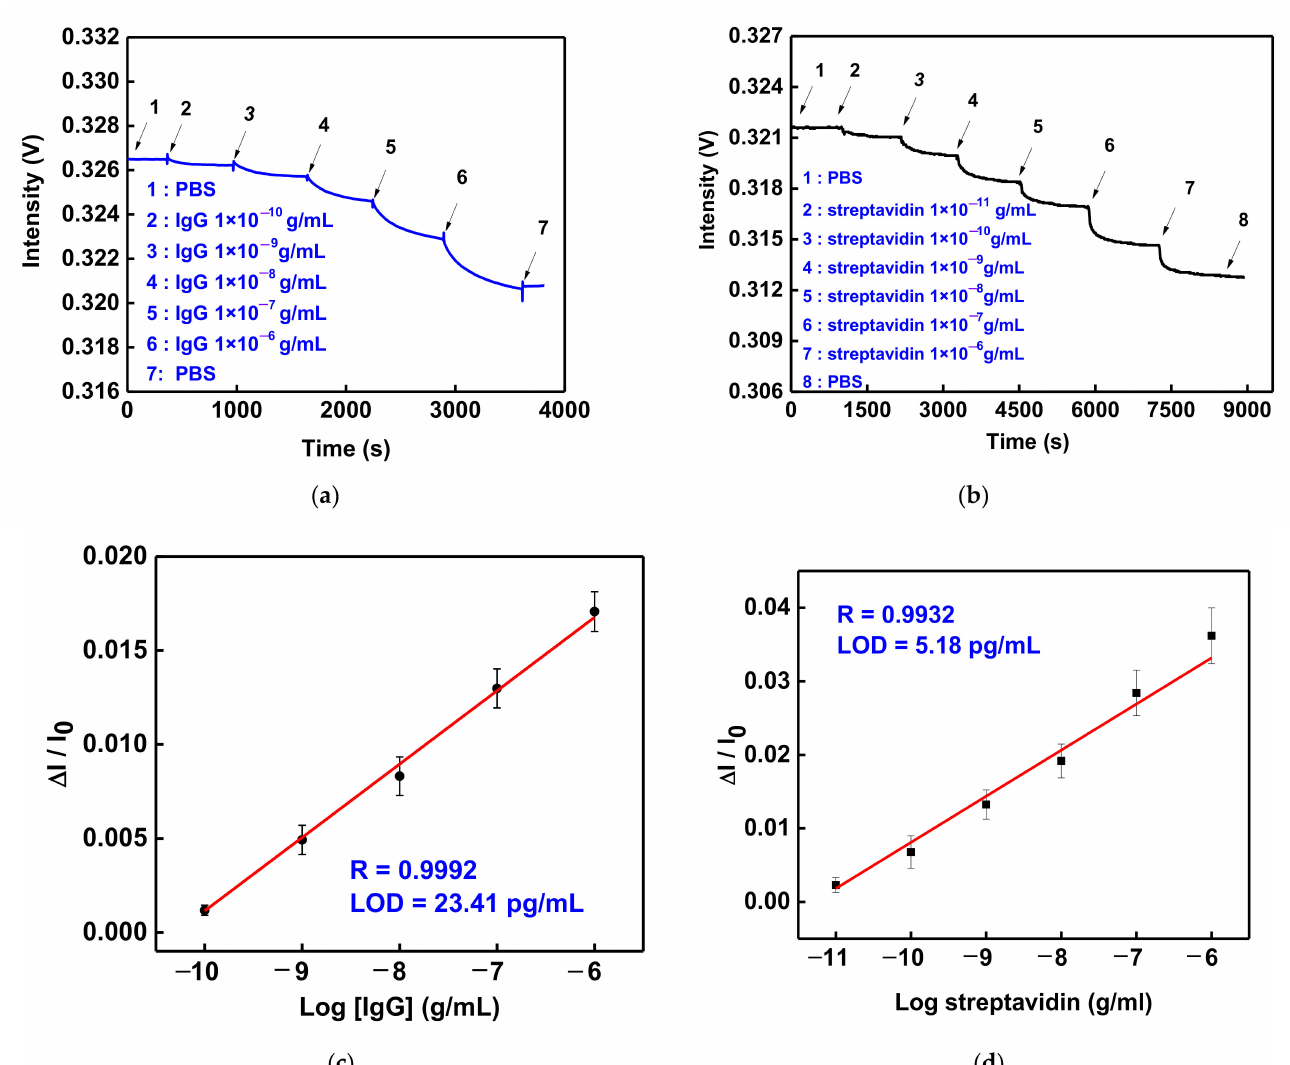
Figure 8. The real-time detection and sensitivity of GO-OW LSPR sensor. ( a ) Temporal response of the anti-IgG-functionalized GO-OW sensing chip signal with serial injection of standard solutions with different IgG concentrations of (1) 1.0 × 10 − 10 , (2) 1.0 × 10 − 9 , (3) 1.0 × 10 − 8 , (4) 1.0 × 10 − 7 , and (5) 1.0 × 10 − 6 g/mL. ( b ) Temporal response of the biotin-functionalized GO-OW sensing chip signal with serial injection of standard solutions with different streptavidin concentrations of (1) 1.0 × 10 − 11 , (2) 1.0 × 10 − 10 , (3) 1.0 × 10 − 9 , (4) 1.0 × 10 − 8 , (5) 1.0 × 10 − 7 , and (5) 1.0 × 10 − 6 g/mL. ( c ) Calibration curve for IgG by anti-IgG-functionalized GO-OW sensing chip. ( d ) Calibration curve for streptavidin by biotin-functionalized GO-OW sensing